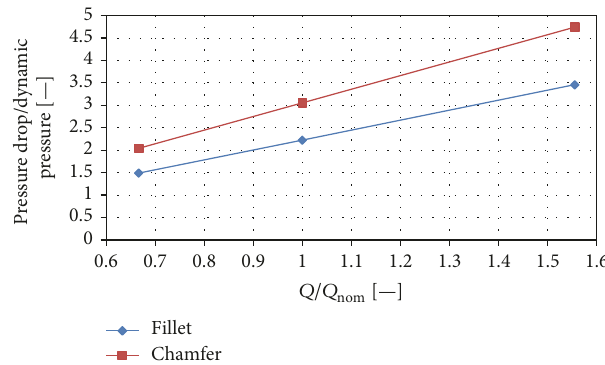
Figure 9: Comparison between fillet and chamfer solutions for the inlet throat.